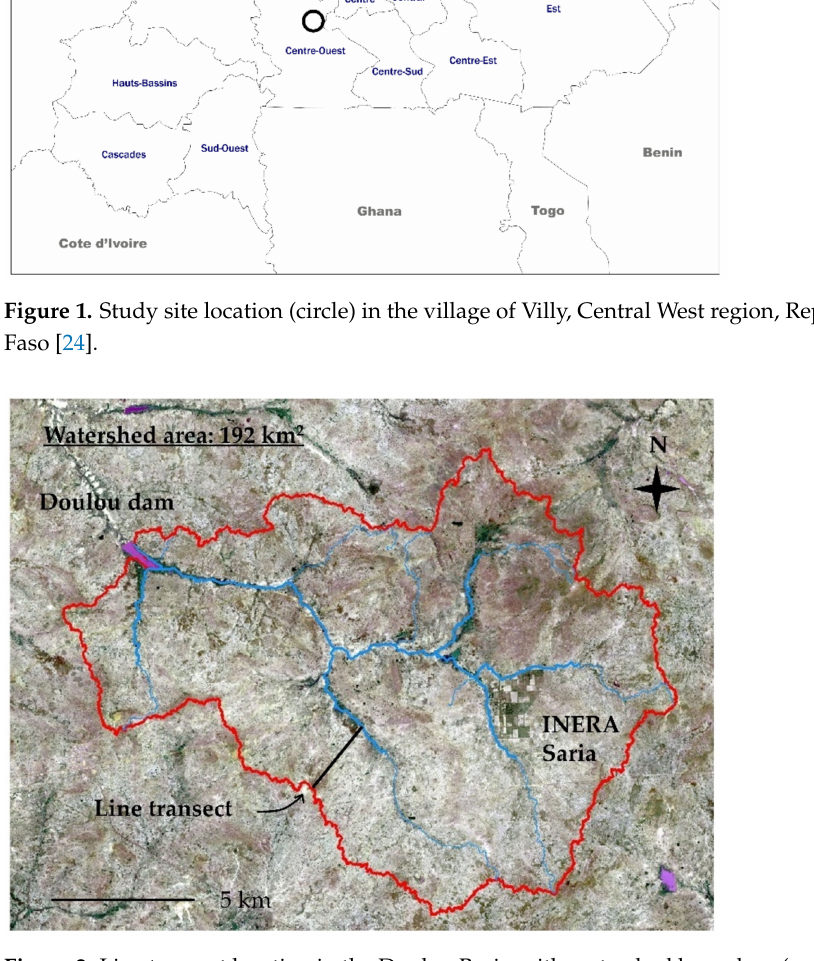
Figure 2. Line transect location in the Doulou Basin with watershed boundary (red line), seasonally dry riverbed locations (blue lines), and water bodies of dams or reservoirs (purple polygons). Location of the Institut de l’Environnemont et Recherches Agricoles (INERA) Saria research station is indicated. Image source: RapidEye AG,